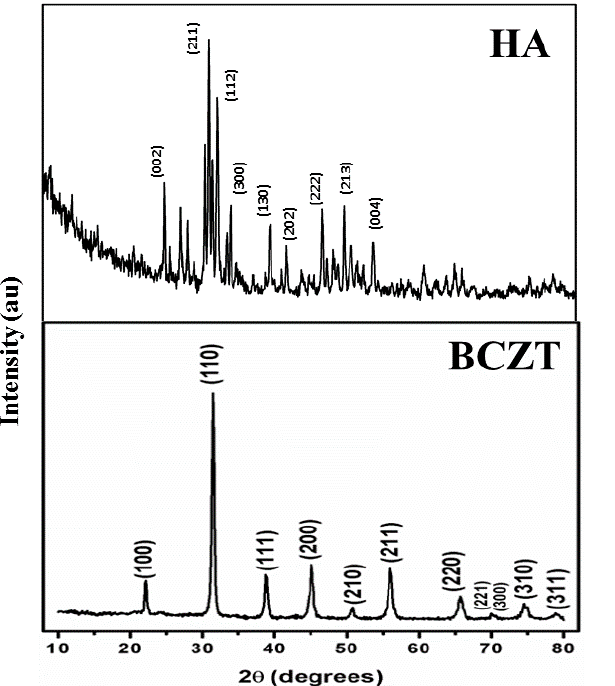
Figure 3: X-ray powder diffraction pattern of HA and BCZT (Ba 0.85 Ca 0.15 Zr 0.1 Ti 0.9 O 3 )